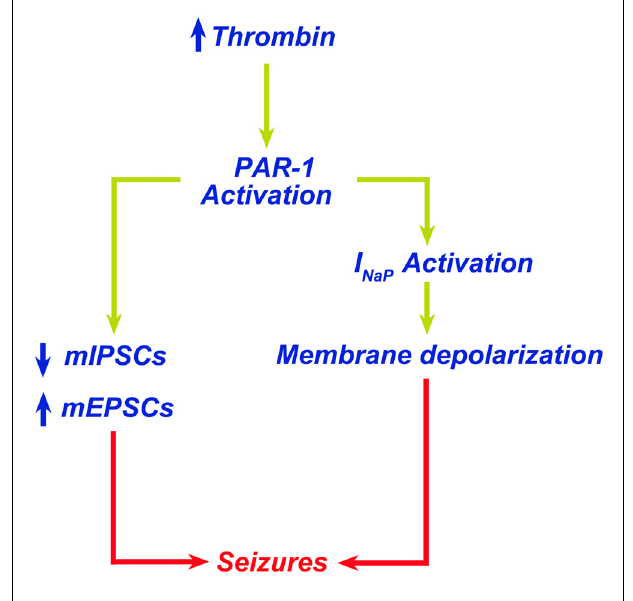
FIGURE 1 |Thrombin leads to seizures through PAR-1 activation. Increased levels of thrombin in the brain lead to PAR-1 activation. PAR-1 promotes membrane depolarization due to activation of I Nap and altered balance of excitatory/inhibitory synapses leading to seizures.